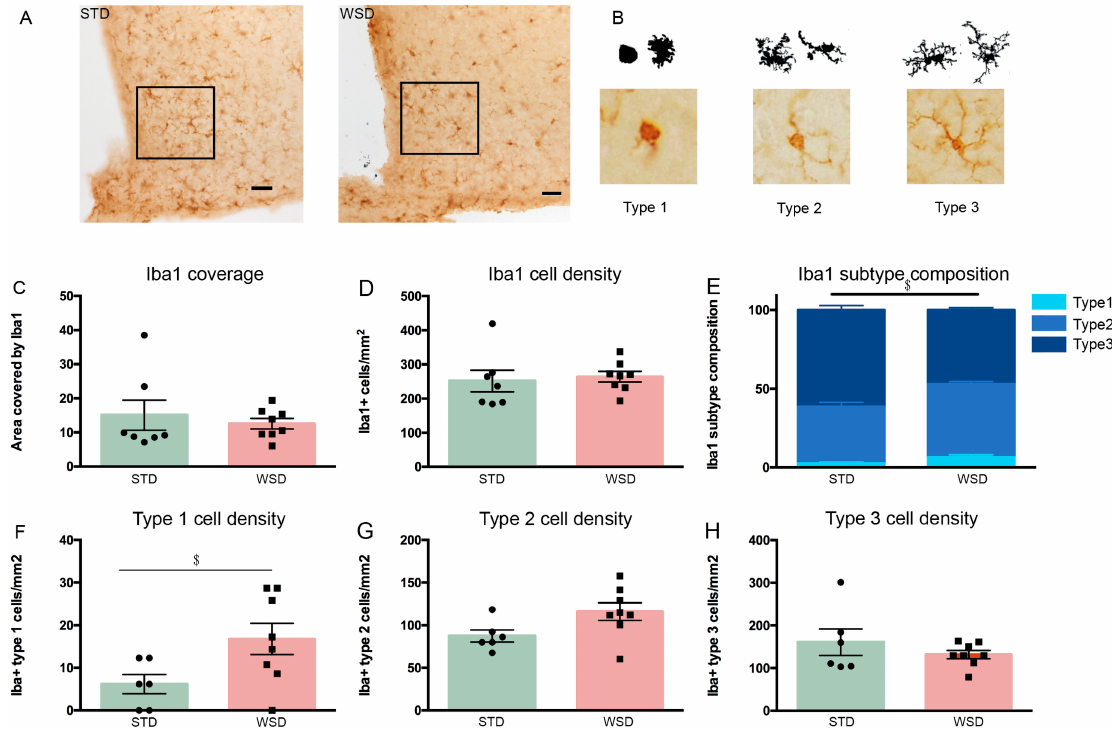
Figure 6. Effects of prolonged WSD exposure on hypothalamic microglia density and coverage. ( A ) Representative images of Iba1 immunostaining. Iba1 immunostaining was analyzed within a defined ROI (black square) in the ARH of STD- and WSD-exposed CTL S-IMF animals. ( B ) Example illustrations of microglia subtypes. ( C ) Iba1 coverage was not affected by WSD. ( D ) Iba1 cell density was not affected by WSD. ( E ) WSD altered Iba1 subtype composition at P230 by increasing the percentage of type 1 microglia. ( F – H ) Iba1 subtype cell densities. WSD increased type 1 cell density. Data are presented as mean ± SEM; scale bars 100 μ m; $ diet effect; p < 0.05.